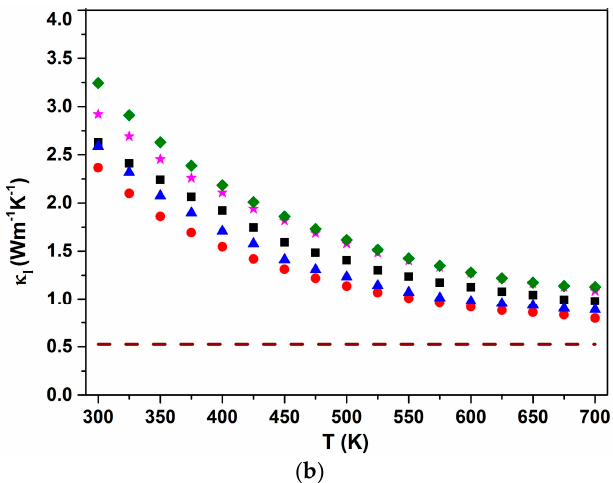
Figure 11. ( a ) Total thermal conductivity ( κ ) and ( b ) lattice thermal conductivity ( κ l ) of graphene/Cu 2 SnSe 3 samples as a function of temperature.